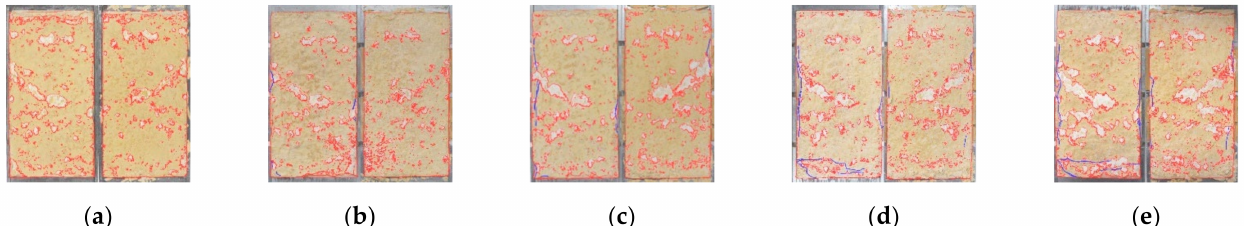
Figure 10. Failure modes of joints with different shear rates under CNS conditions. ( a ) Shear rate = 0.5 mm/min; ( b ) Shear rate = 2.5 mm/min; ( c ) Shear rate = 5 mm/min; ( d ) Shear rate = 10 mm/min; ( e ) Shear rate = 20 mm/min.